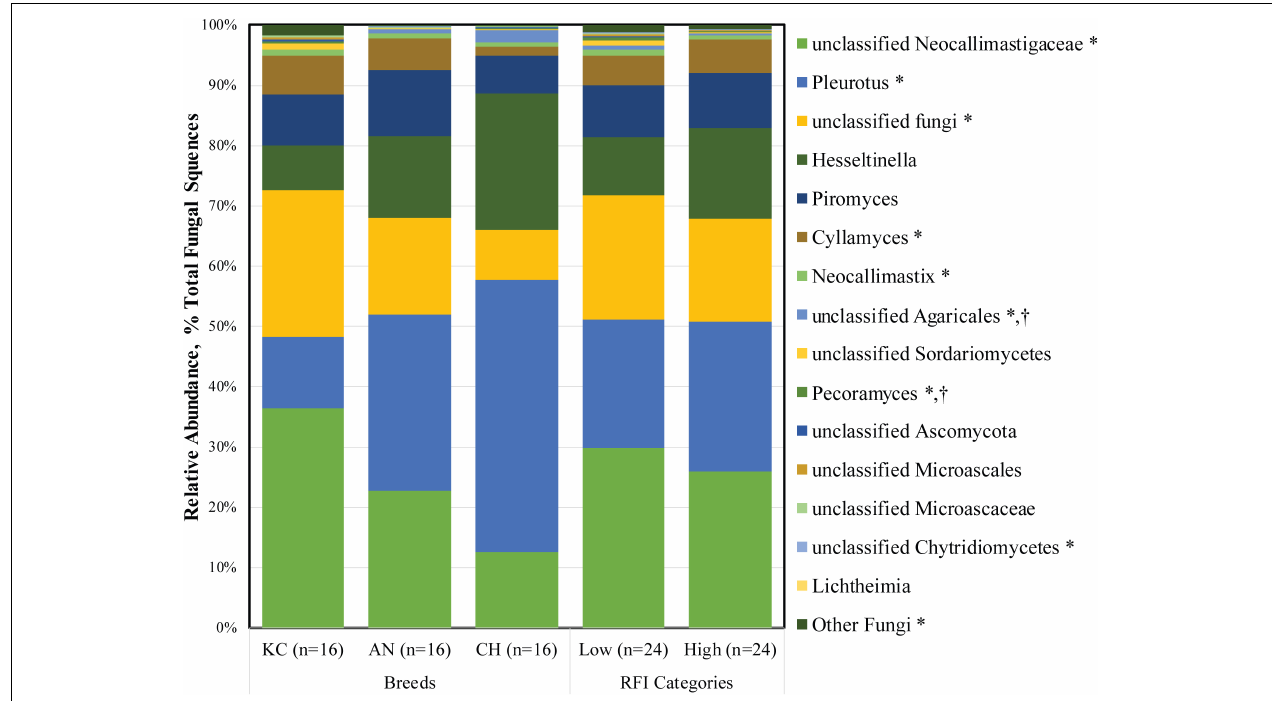
FIGURE 3 | Active rumen fungal composition at the genus level in beef cattle of three breeds and divergent residual feed intake (RFI). Taxa name with asterisk (*) represents significant breed effect ( P < 0.05), and taxa name with dagger ( † ) represents significant RFI effect ( P <